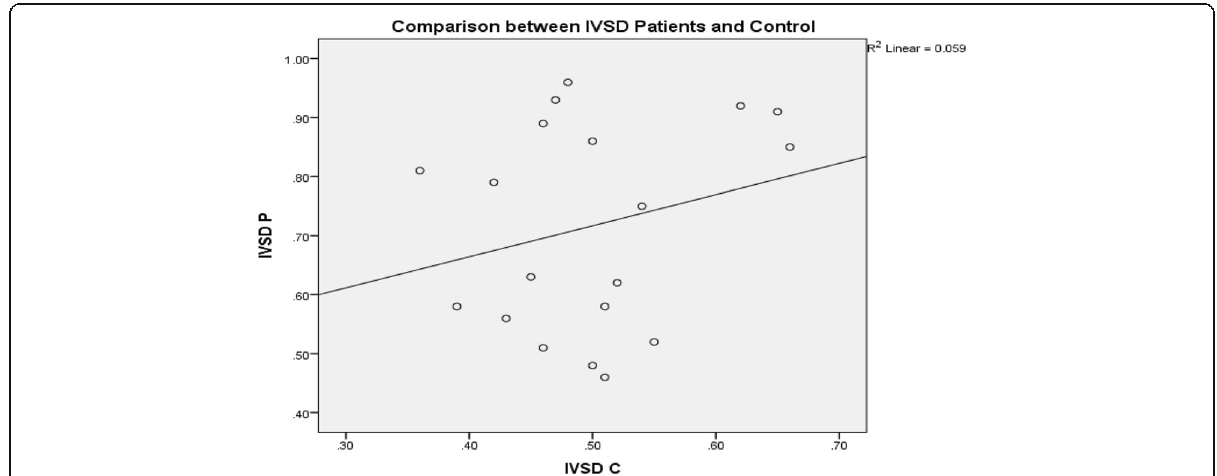
Fig. 1 Linear regression curve to illustrate significant correlation between IVST for both patients and controls (correlation coefficient R 2 = 0.244)